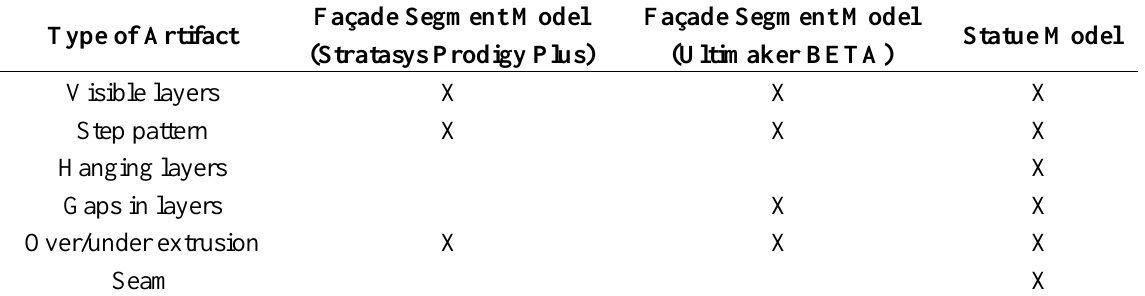
Table 3. Visible artifacts caused by rapid prototyping (RP) machines found in the